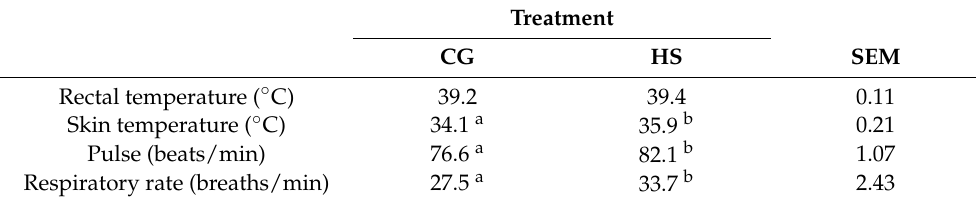
Table 3. The physiological indices of goats.